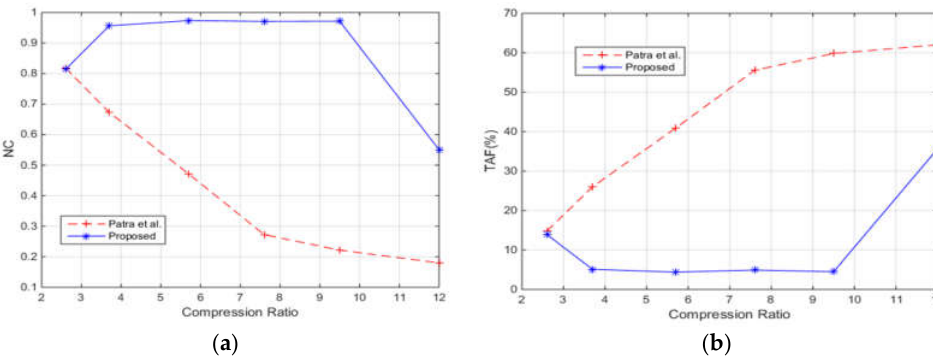
Figure 5. Performance of compression attack on Mandrill image on ( a ) NC vs. Compression ratio; and ( b ) TAF vs. Compression ratio.